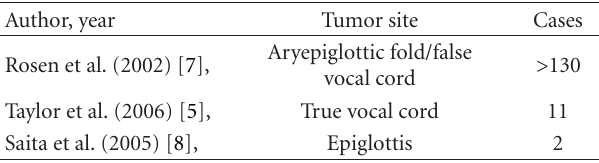
Table 1: A review of literature of laryngeal schwannoma.